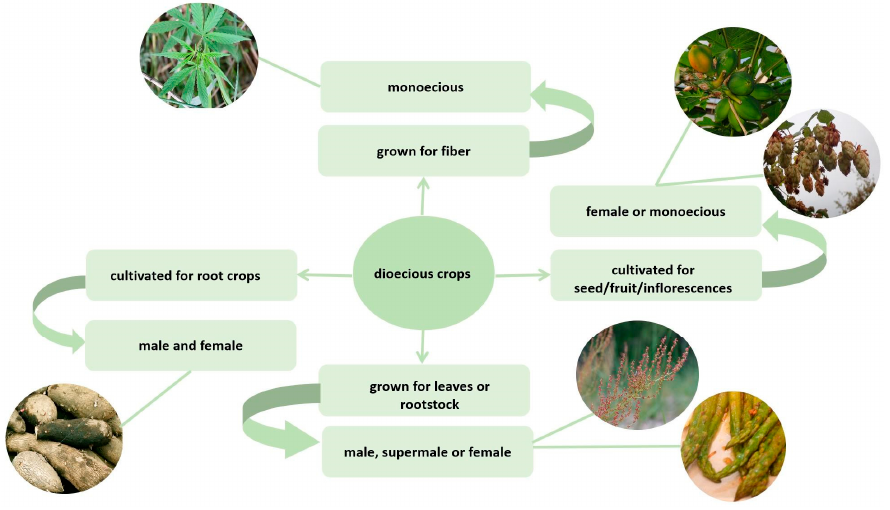
Figure 1. The use of dioecious plants depending on its